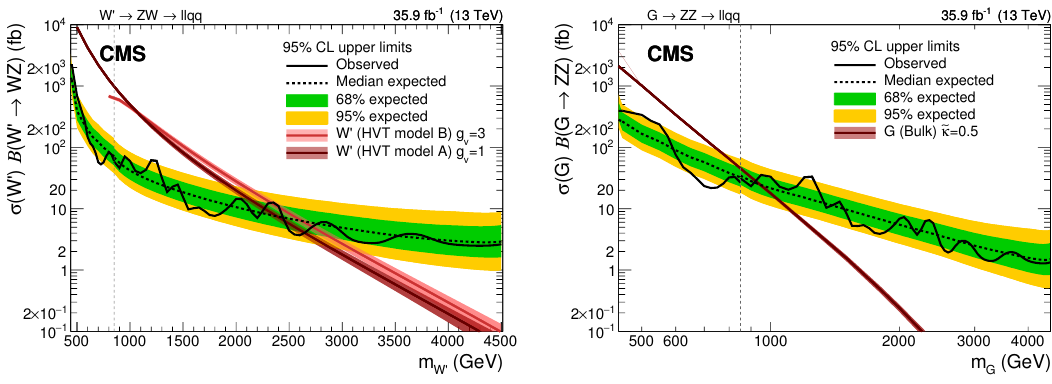
Figure 6 . Observed and expected 95% CL upper limit on (cid:27) W 0 B (W 0 ! ZW) (left) and (cid:27) G B (G ! ZZ) (right) as a function of the resonance mass, taking into account all statistical and systematic un- certainties. The electron and muon channels and the various categories used in the analysis are com- bined together. The green (inner) and yellow (outer) bands represent the 68% and 95% coverage of the expected limit in the background-only hypothesis. The dashed vertical line represents the tran- sition from the low-mass to the high-mass analysis strategy. Theoretical predictions for the signal production cross section are also shown: (left) W 0 produced in the framework of HVT model A with g v = 1 and model B with g v = 3; (right) G produced in the WED bulk graviton model with